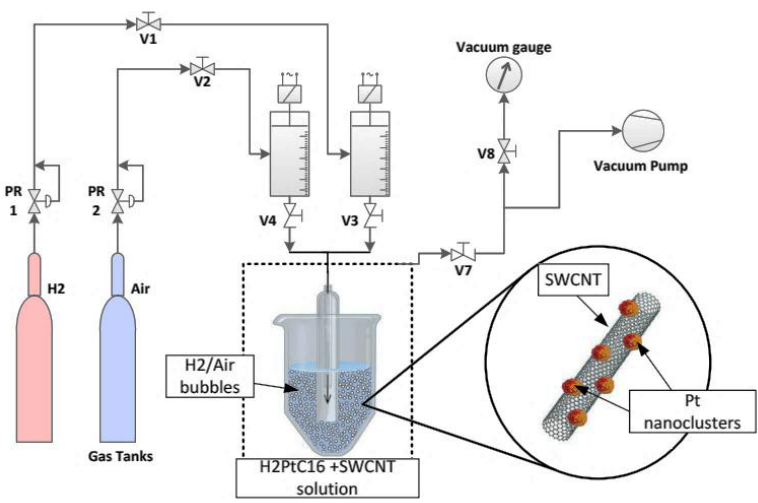
Figure 1. Schematic view of sensing fabrication unit with gas distribution system.